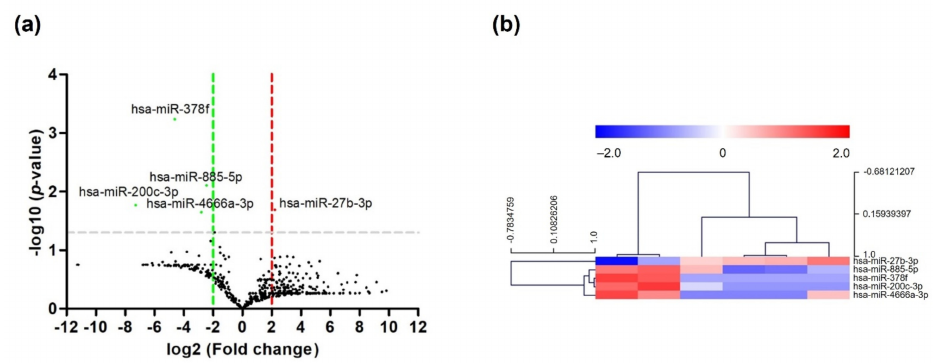
Figure 1. Volcano plot and heatmap for the identification of DE miRNAs. ( a ) Volcano plot of DE miRNAs in plasma samples of GC patients who received fewer than 4 cycles and received 4–7 cycles of XELOX chemotherapy. Log2 fold changes between patients who received fewer than 4 cycles and received 4–7 cycles of XELOX chemotherapy are plotted on the x -axis, and the –log10 of the p -value is plotted on the y -axis. Red: upregulated miRNA; green: downregulated miRNA; ( b ) heatmap of miRNA expression data from plasma samples of GC patients who received fewer than 4 cycles and received 4–7 cycles of XELOX chemotherapy; red: upregulated miRNA; blue: downregulated